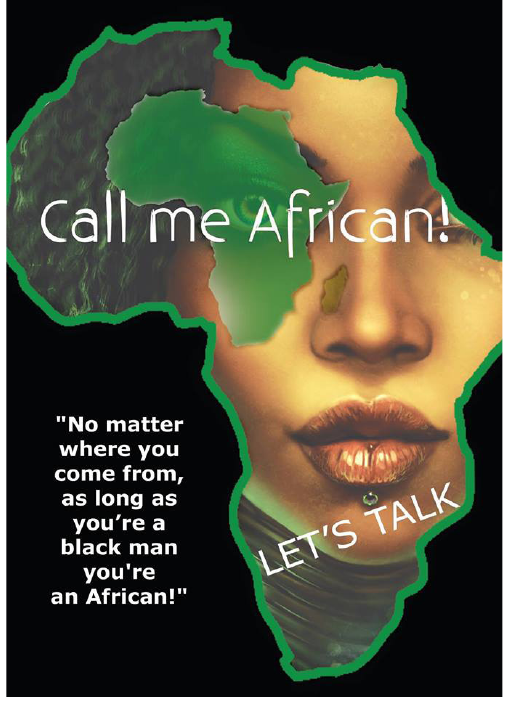
Figure 1. Call me African!